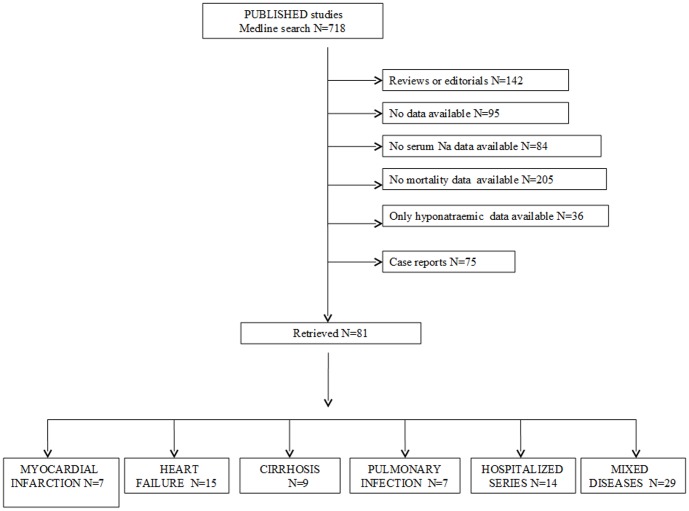
Trial flow diagram.